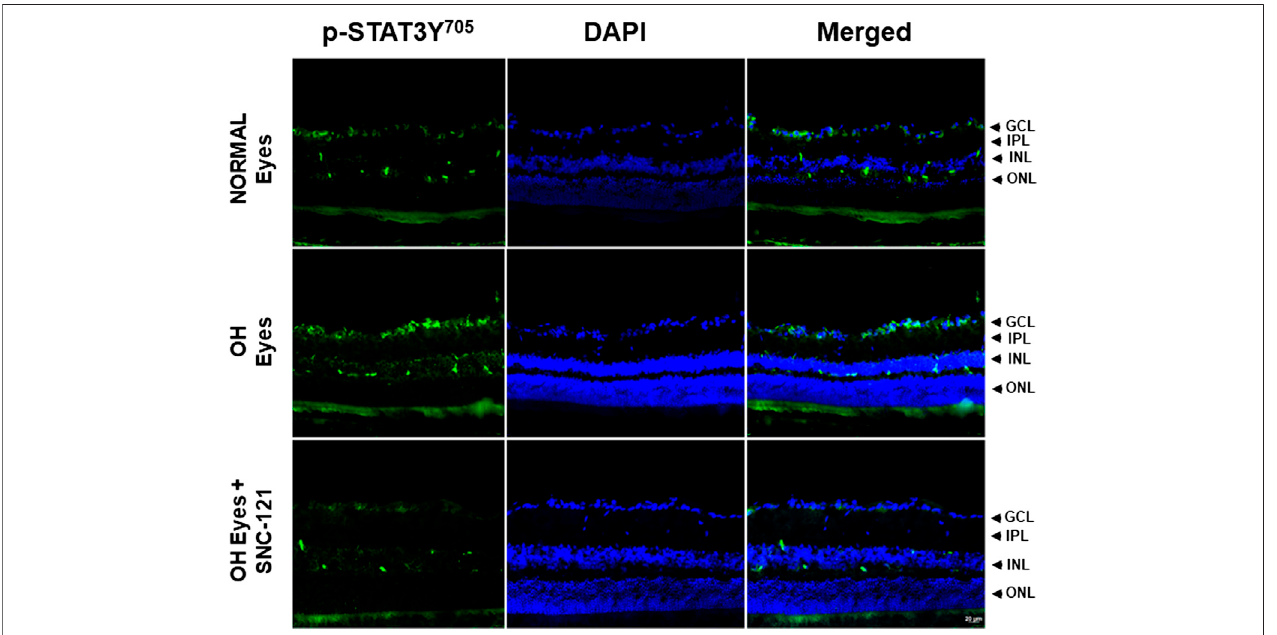
FIGURE 5 | Changes in the signal transducer and activator of transcription 3 (STAT3) phosphorylation in response to ocular hypertension and δ -opioid receptor agonist (SNC-121) treatment. The retina from normal, ocular hypertensive, and SNC-121 treated ocular hypertensive animals were collected at day 7, post hypertonic saline injection. Retina cryosectionswereimmunostained using aselectiveanti-phosphoSTAT3 (Tyr 705) antibody and the nuclei werecounterstained withDAPI.Green color indicates staining for phosphorylation of STAT3 and blue for the nuclei. There was no positive immunostaining when primary antibodies were omitted (not shown).Datashownhereisarepresentationofatleastfourindependentexperiments.Wehaveusedfouranimalsineachtreatmentgroup.OHEyes;ocularhypertensive eyes; OH Eyes + SNC-121, ocular hypertensive eyes with SNC-121 treatment, bar size 20